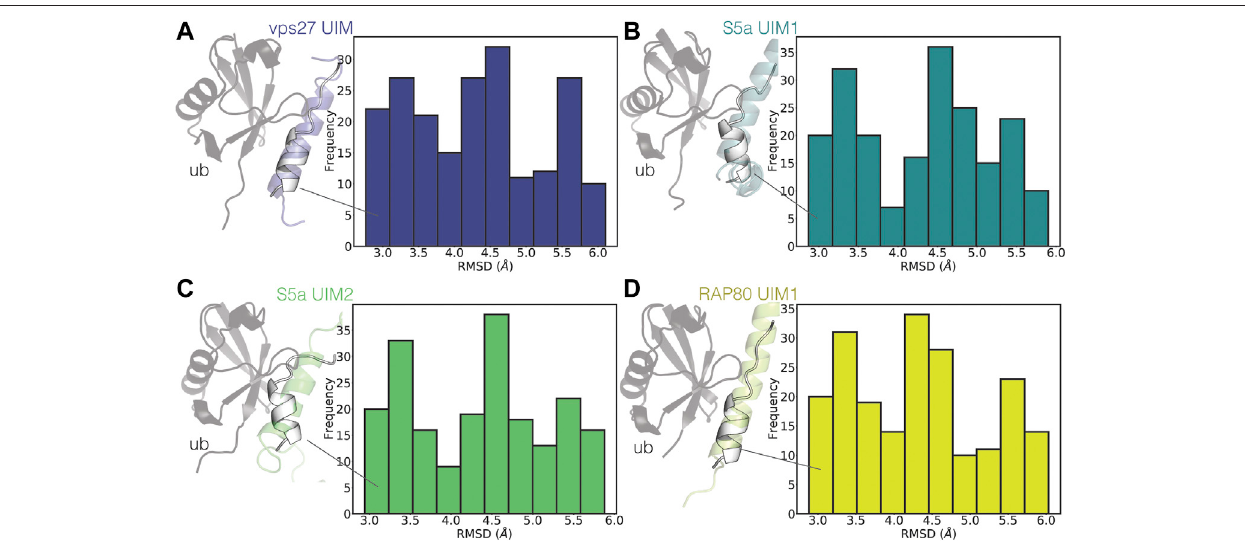
FIGURE6| UIM3ofAT-3 306-361 samplesstatespartiallyresemblingubiquitin-boundconformations.TheplotsshowtheRMSDcalculationsofUIM3ofAT-3 306-361 from the CHARMM22* 2 metadynamics trajectory, using as a reference the experimental structure of the UIMs of other proteins in complex with ubiquitin (A) VPS27 UIM (PDB entry1Q0W,blue), (B) S5aUIM1 (PDBentry1YX5,teal), (C) S5aUIM2(PDBentry1YX6,green), (D) RAP80 UIM1(PDBentry3A1Q,yellow).WecalculatedRMSD for the ensembles of structures of UIM3 with alphabeta values in the range of 31-34. The cartoon representations show the structures of the experimental complexes, with the ubiquitin monomers shown as gray cartoons. The white cartoon representation shows the conformations of UIM3 (residues 336 – 350) from the CHARMM22* 2 metadynamics simulation with the lowest RMSD to each experimental